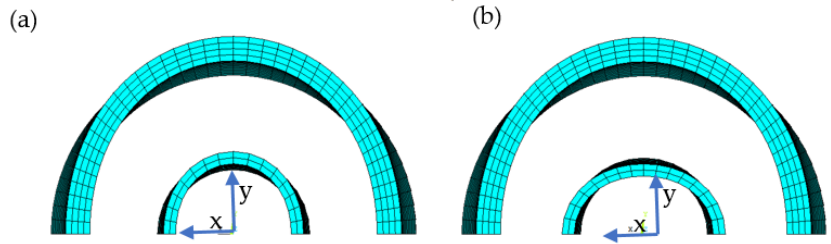
Figure 9. Directions of ovality of outer and inner pipe: ( a ) same and ( b ) vertical.